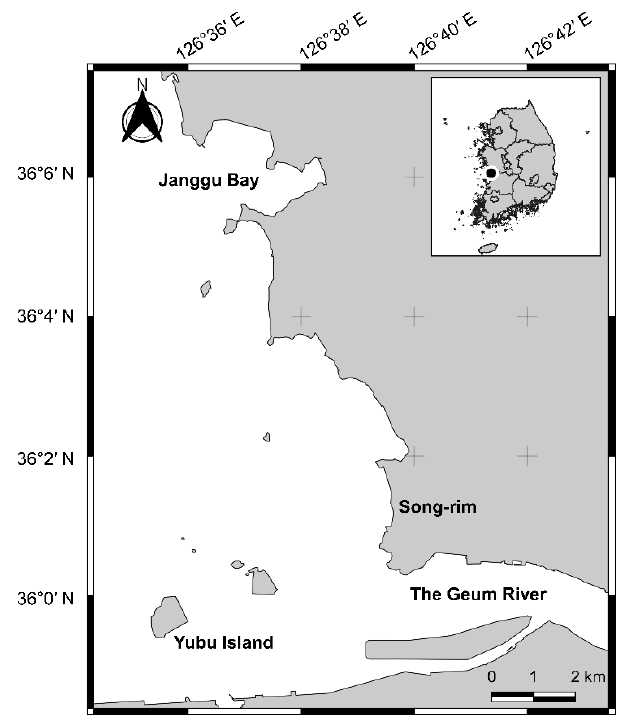
Figure 1. Map of the study area based on the GPS tracking dataset.